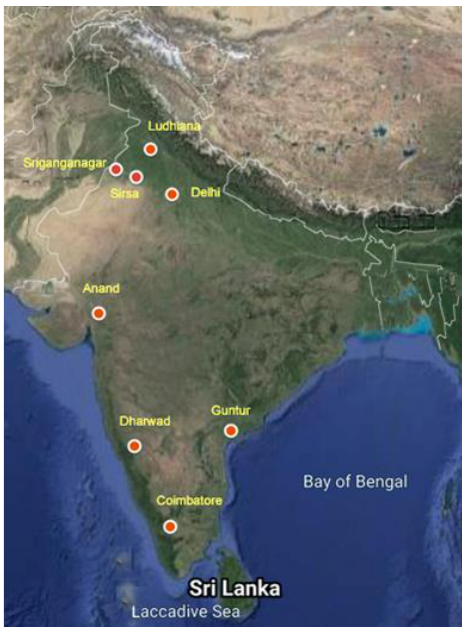
Figure 1. Different locations of collection of CZS populations from India.